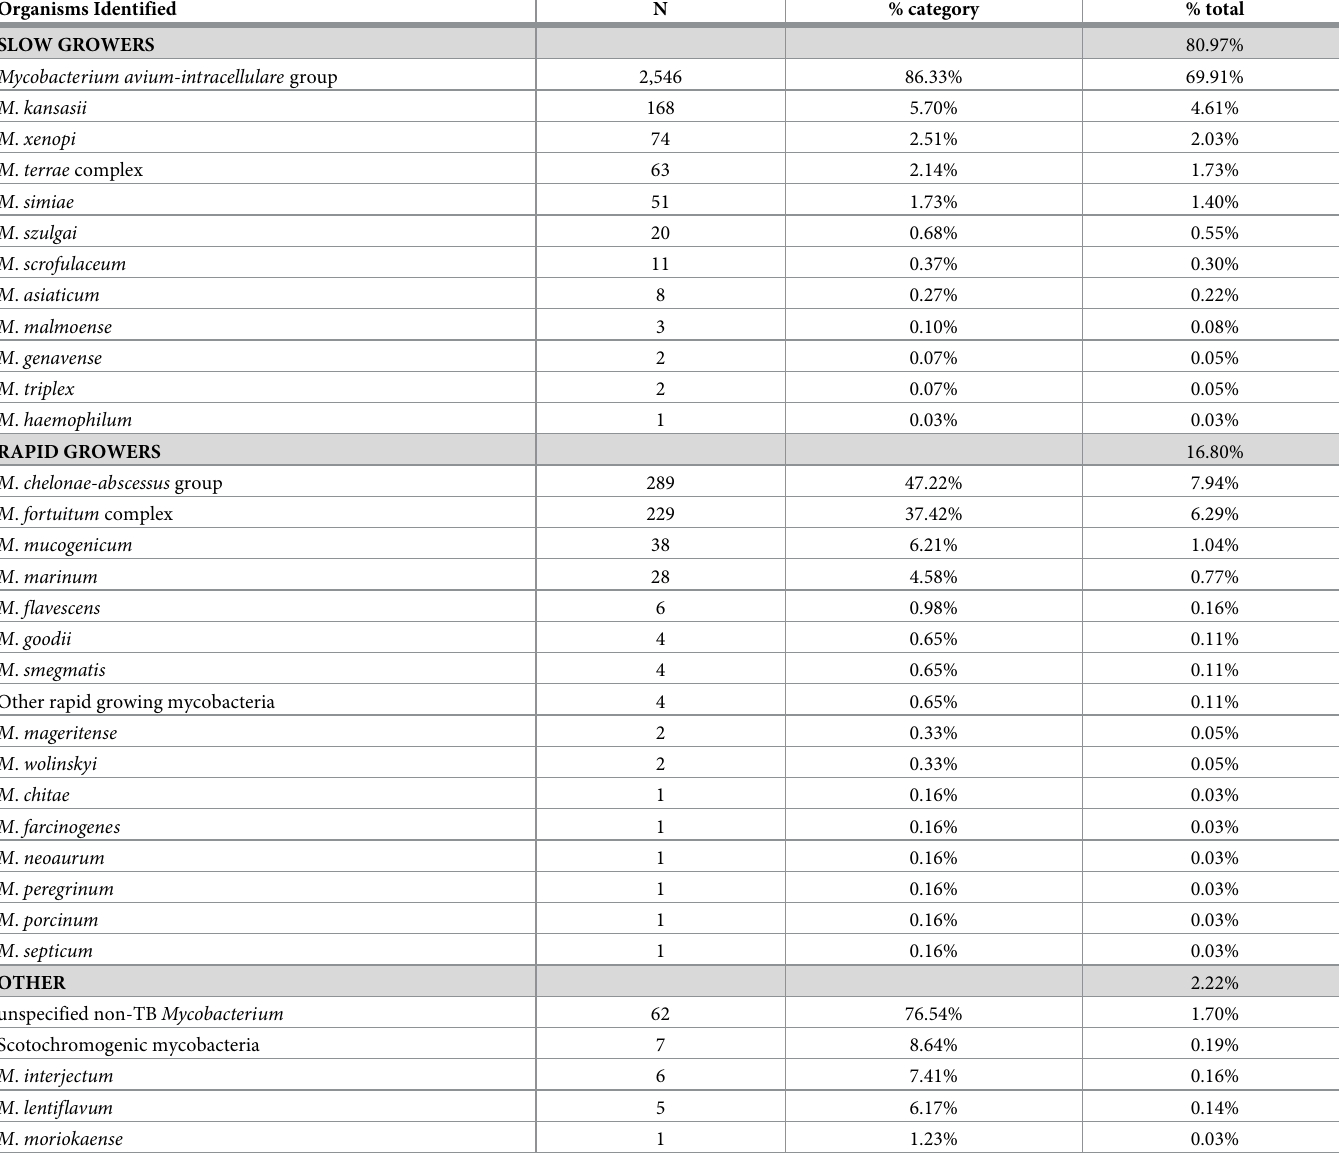
Table 1. Mycobacterial categories found in microbiology and laboratory data in